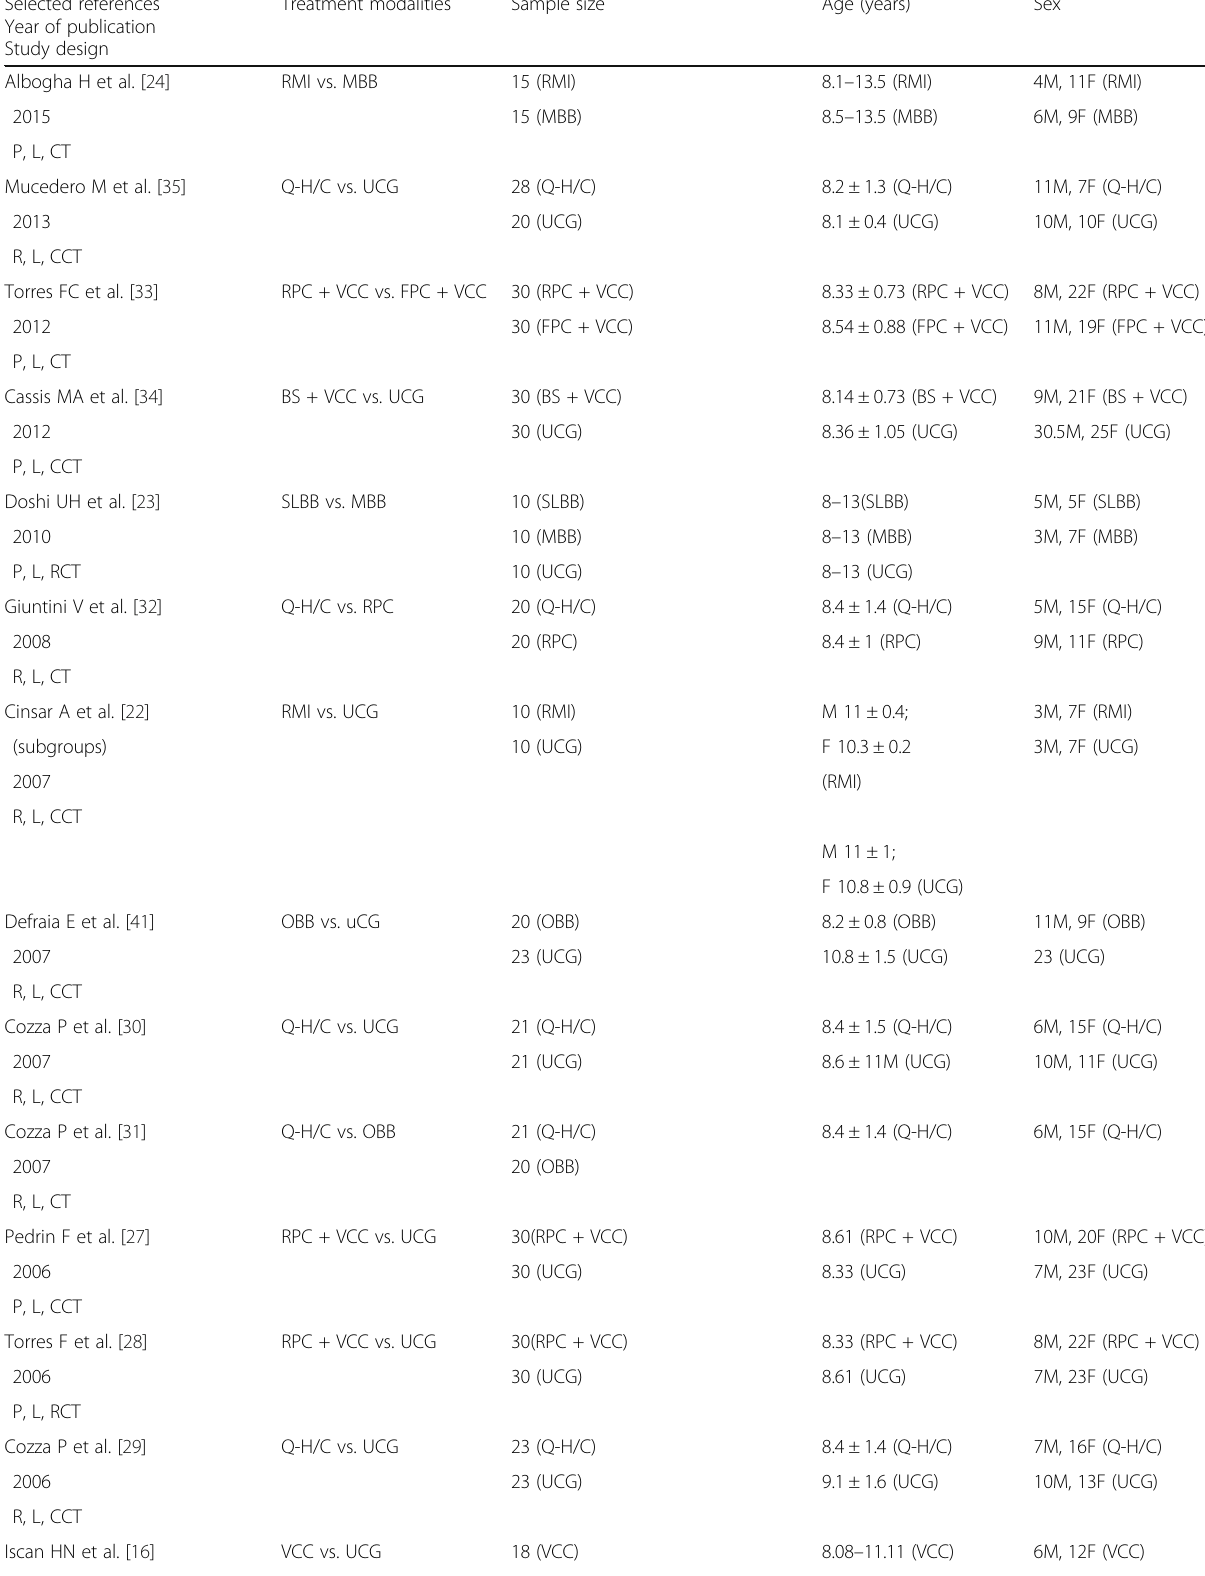
Table 1 Results: trial design, treatment modalities, characteristics of the